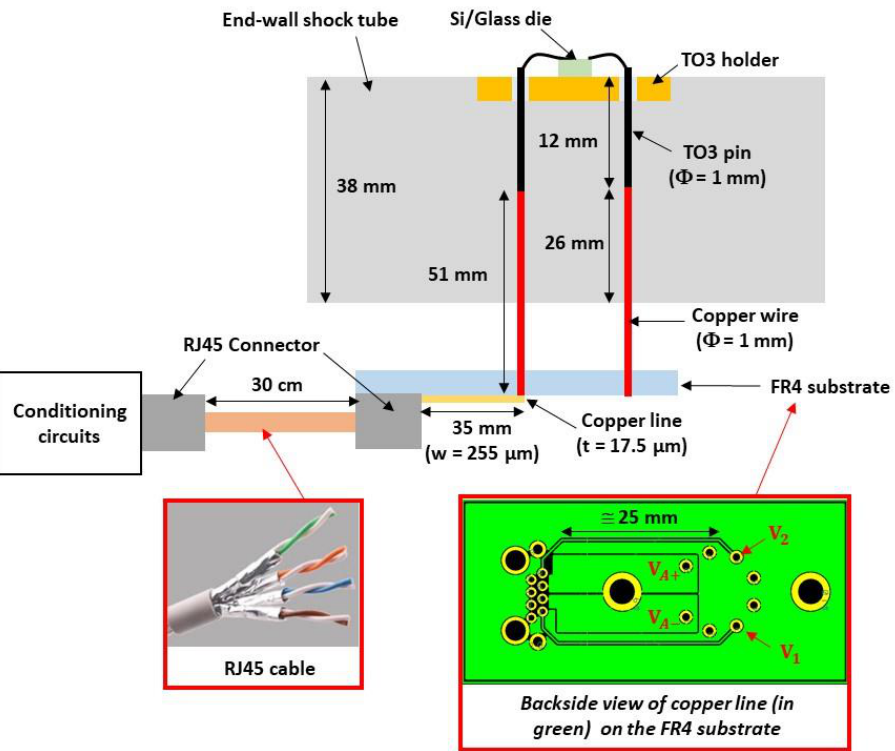
Figure 19. Description of electrical interconnections between the transducer and the conditioning circuit.